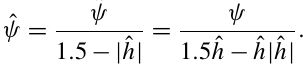
considered as a measure of the blade local curvature.